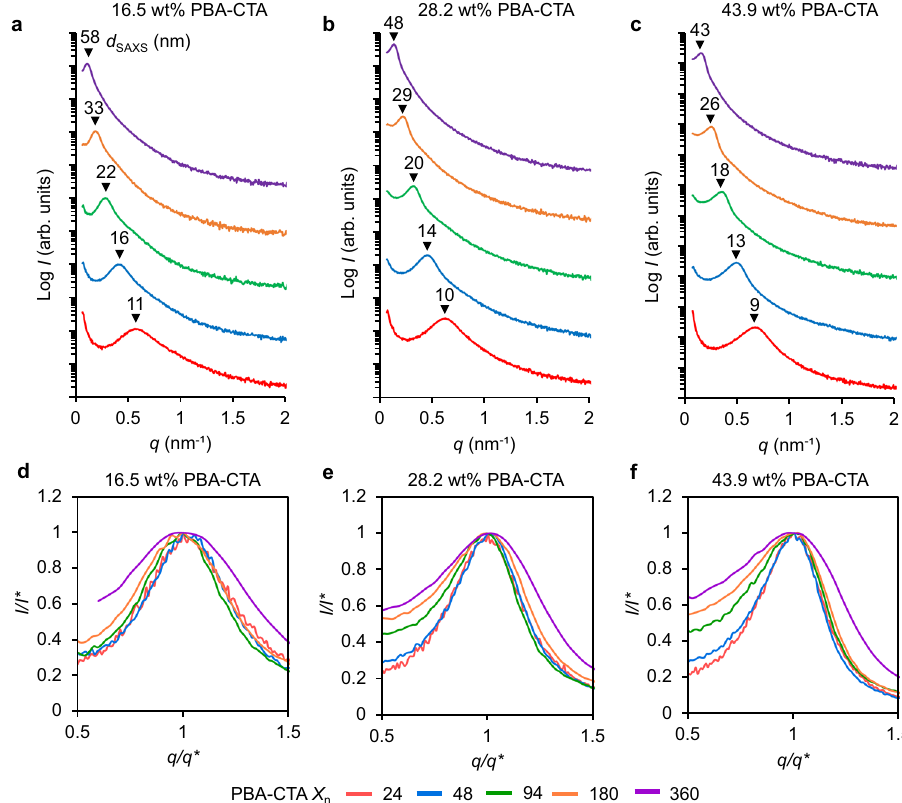
Fig. 4 SAXS data for materials 3D printed using PIMS resins. a – c SAXS pro fi les and corresponding domain spacing ( d SAXS ) values of materials 3D printed using varied PBA-CTA wt%: a 16.5 wt% PBA-CTA; b 28.2 wt% PBA-CTA; c 43.9 wt% PBA-CTA. SAXS pro fi les were shifted vertically for clarity. d – f Scaled SAXS data showing comparison of peak broadness for materials 3D printed with various degree of polymerization ( X n ) and PBA-CTA wt%: d 16.5 wt% PBA-CTA; e 28.2 wt% PBA-CTA; f 43.9 wt% PBA-CTA. For the data shown in d-f, the SAXS spectra were normalized based on the intensity ( I* ) and the position ( q* ) of the principal peaks.